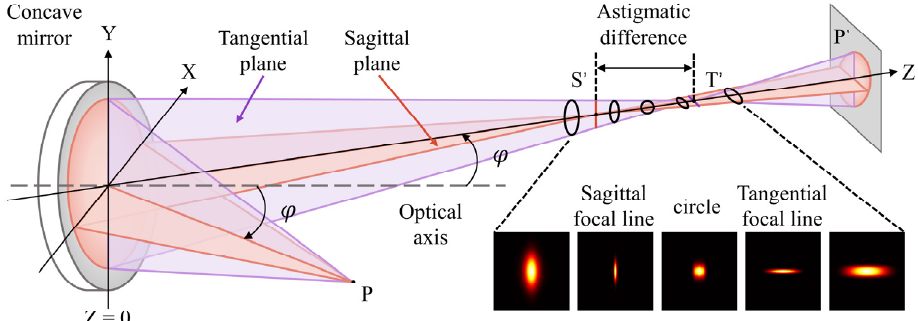
Figure 1. Schematic of astigmatic aberration produced by a concave mirror. Assume a femtosecond laser pulse with Gaussian spatial profile is incident to a concave mirror at angle of 𝜑 and focused along the z direction. The optical axis is the normal direction of the concave mirror and the incident angle 𝜑 is in the sagittal plane. It is worth noting that if 𝜑 is in the sagittal plane, the sagittal focal line appears first, and the tangential focal line appears after. If 𝜑 is in the tangential plane, the sign of the astigmatism is opposite.